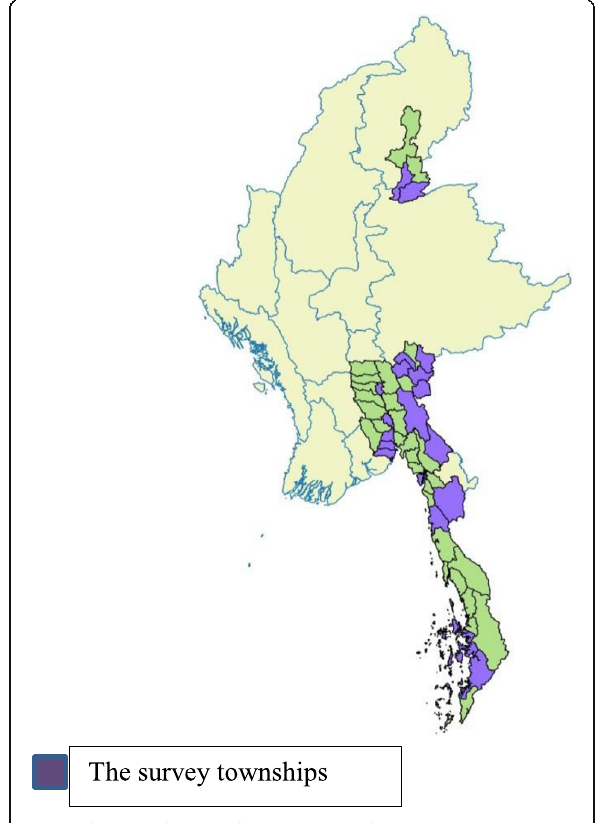
Fig. 1 The map showing the survey townships among RAI project